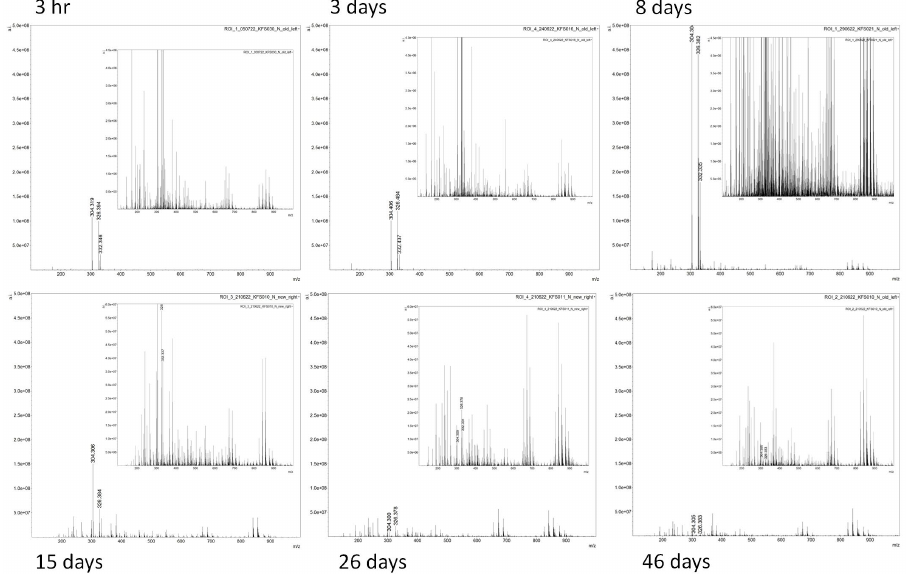
Figure 3. Representative mass spectra extracted from the data used to generate the images in Figure 2 by drawing regions of interest in the outermost left (older) and outermost right (younger) sides of the ion images, where the fingermarks do not overlap. The intensity is normalized to the total-ion-chromatogram for each spectrum. The two major ions at m / z 304 and 326, observed with the highest relative abundance in the younger fingermarks (the first two ions labelled in the spectra), have previously been identified as dodecylbenzyldimethylammonium and didecyldimethylammonium ions, respectively, and are common antibacterial products used, e.g., in hand-sanitizers [20–22].